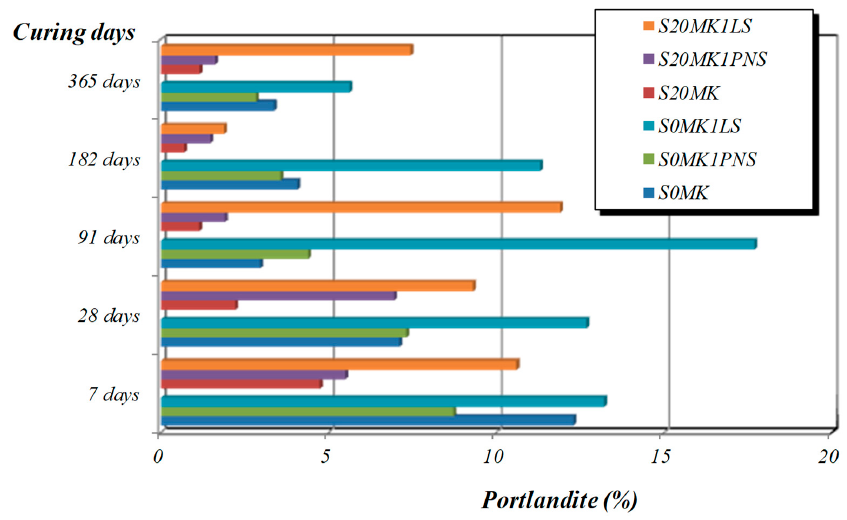
Figure 7. Percentages of Ca(OH) 2 for mortars at different curing times.